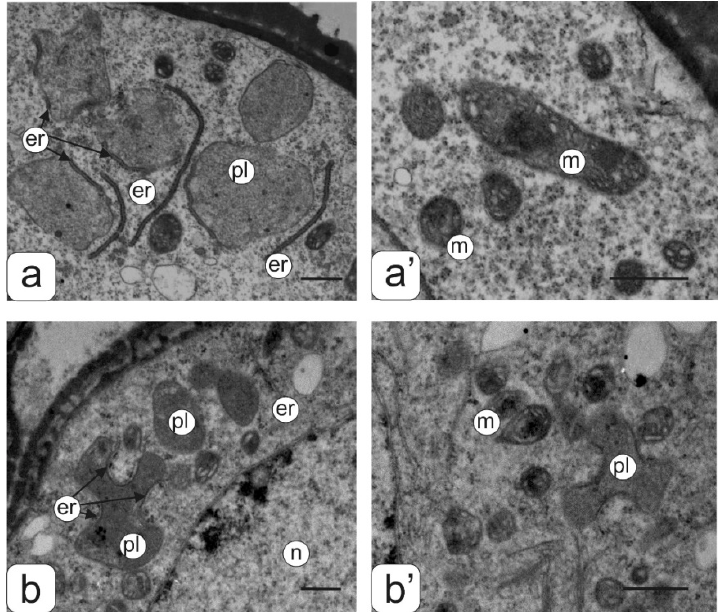
Figure 3. Ultrastructure of the cytoplasmic fragment from the microspore of normal ( a , a ’) and transgenic ( b , b ’) tomato anthers with an abnormal phenotype. Plastids membranes–ER association ( a , b ) and mitochondrial ultrastructure ( a’ , b’ ). Symbols: er—endoplasmic reticulum, m—mitochondria, n—nucleus; pl—plastids. Bar—1 μ m.